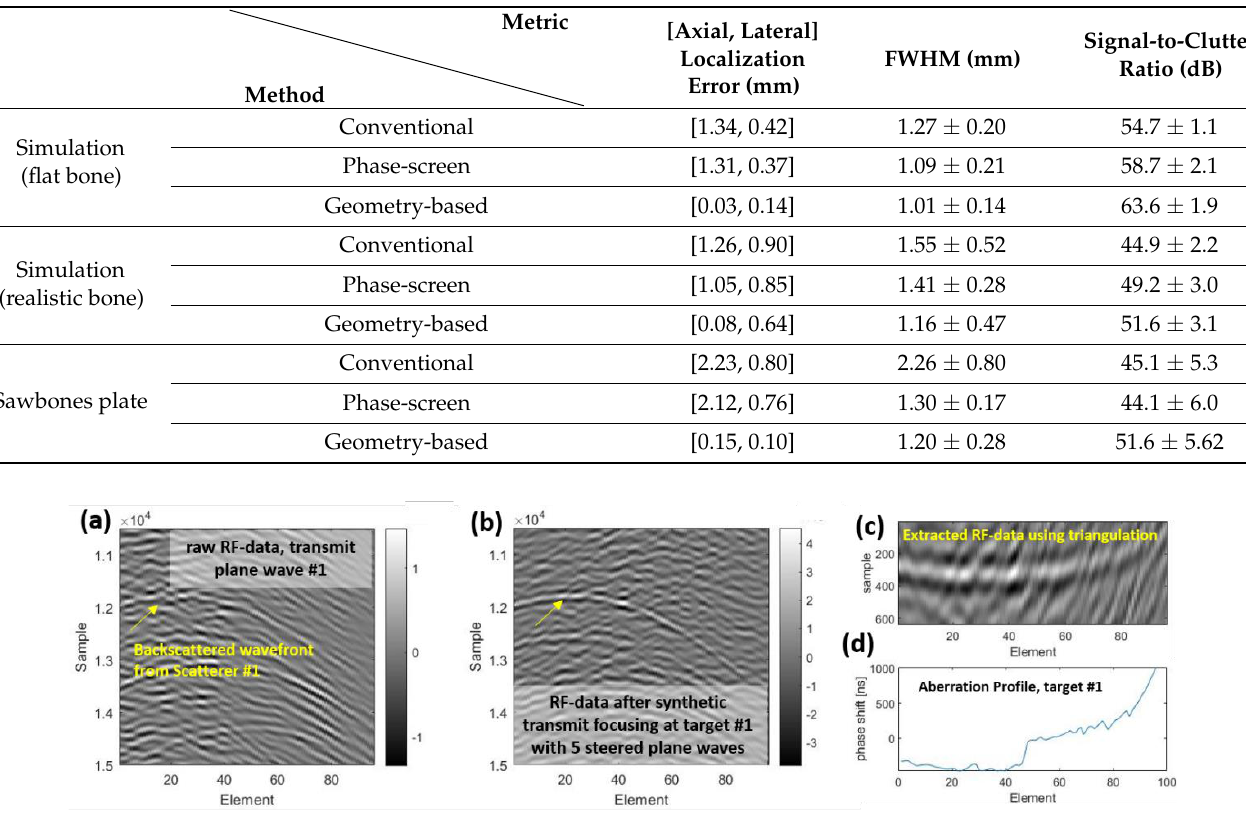
Figure 6 . Estimation of the aberration profile with the numerical dataset generated with the flat bone model and a heterogeneous background. The wavefront backscattered from ( a ) scatterer #1 and ( e ) scatterer #2; a tilted plane wave (by 7.5 degrees in cutaneous tissue) was used for excitation. The numerical wavefront backscattered by ( b ) scatterer #1 and ( f ) scatterer #2 after synthetic transmit focusing on the locations of scatterer #1 and #2, respectively, by coherent compounding of the RF data generated by 5 tilted plane waves (from −15 to 15 degree in cutaneous tissue). ( c , g ) The ex- tracted wavefront using triangulation for scatterer ( c ) #1 and ( g ) #2. The estimated phase shift (ab- erration profile) in nanoseconds for scatterer ( d ) #1 and ( h ) #2.